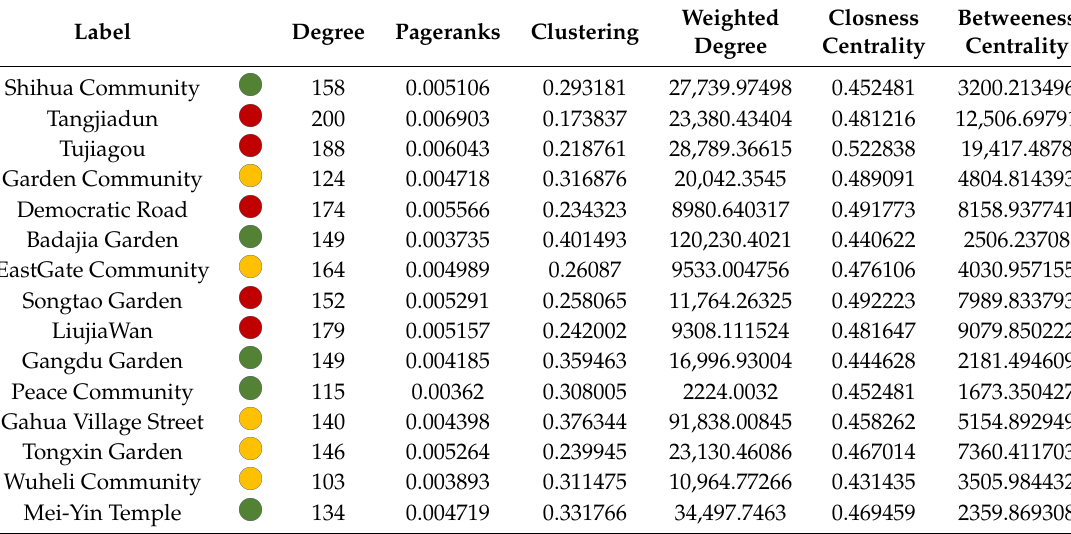
Table 2. Community node characteristics of the first 15